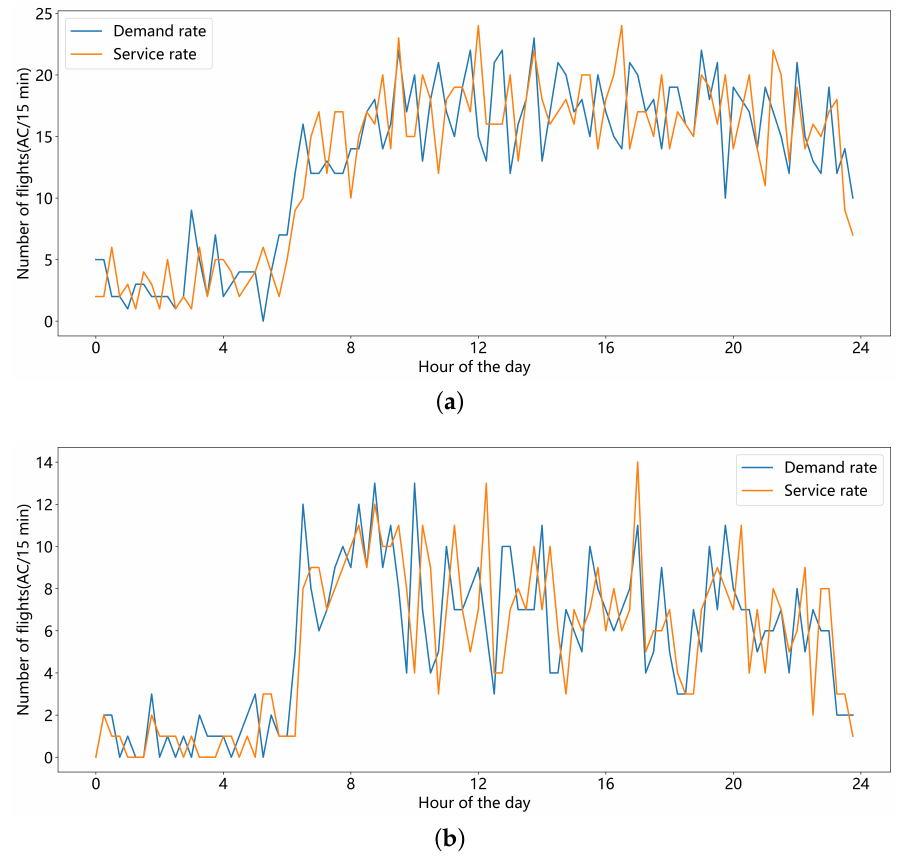
Figure 7. Demand and service profile at airport and waypoint. ( a ) Demand and service profile at ZGGG; ( b ) Demand and service profile at